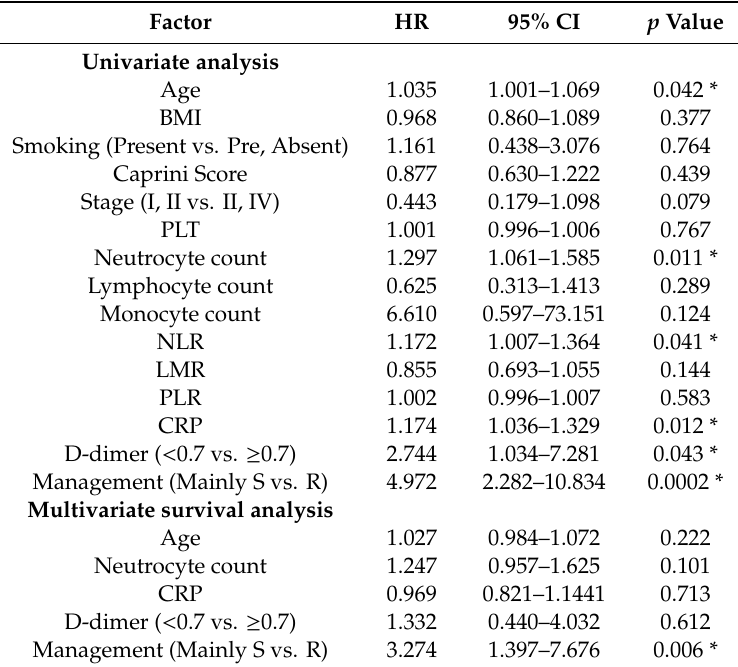
Table 4. Prognostic factors for overall survival a .